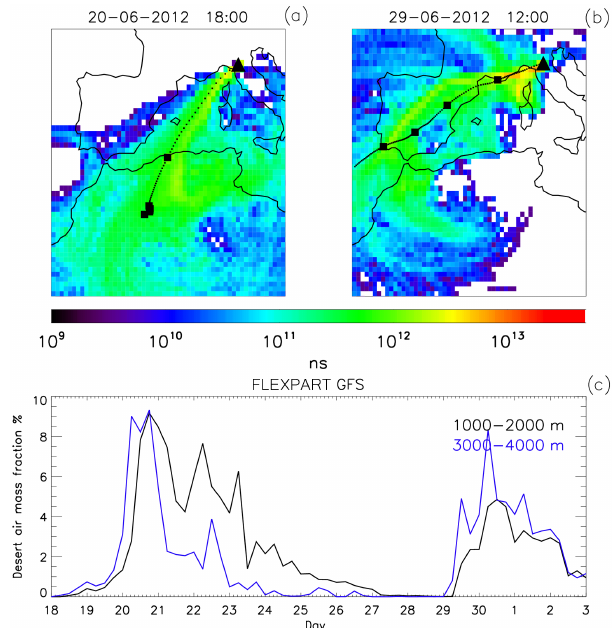
Figure 6. FLEXPART back-trajectories over GFS meteorological input: panels (a) and (b) show the footprint (in nanoseconds of resi- dence over each bin) of the trajectories released over SPC at 3000m. Black triangle indicates the point of release, and black squares mark the position of the centre of mass every 24h. The pattern of trajec- tories released on 20 June at 18:00UTC are shown on the left (a) , while pattern released on 29 June at 12:00UTC are on the right (b) . The simulated mass fraction contribution of dust over the SPC site is reported in (c) with a time step of 6h. The black line is relative to the particles released in the 1000–2000m atmospheric layer and the blue line to the release at 3000–4000m.